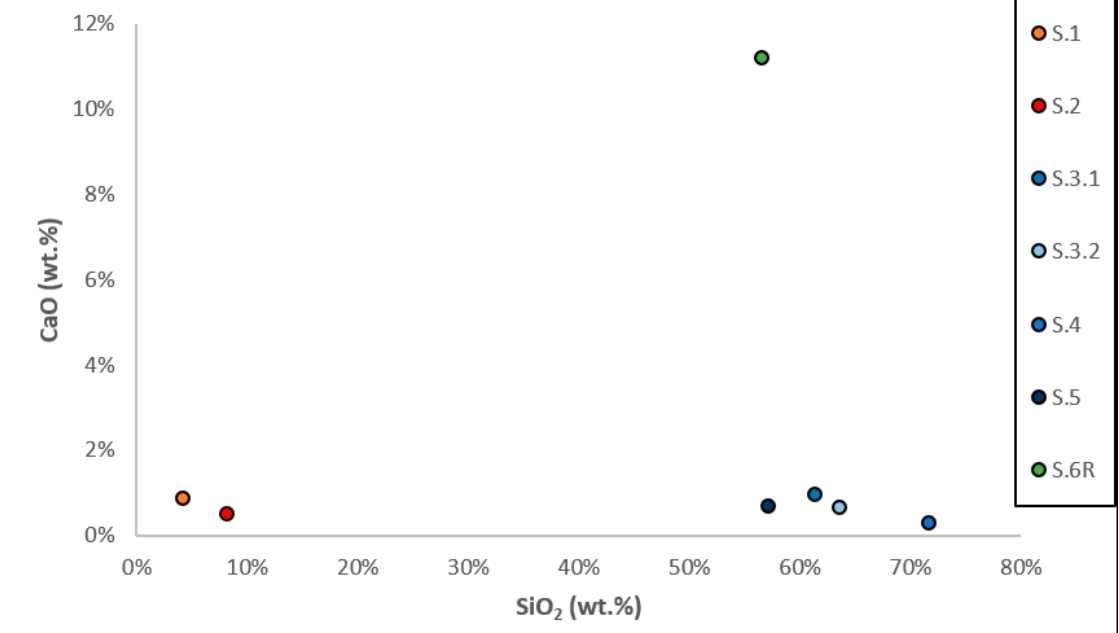
Figure 8. XRF data. Scatter plot SiO 2 -CaO, color coded by sample.